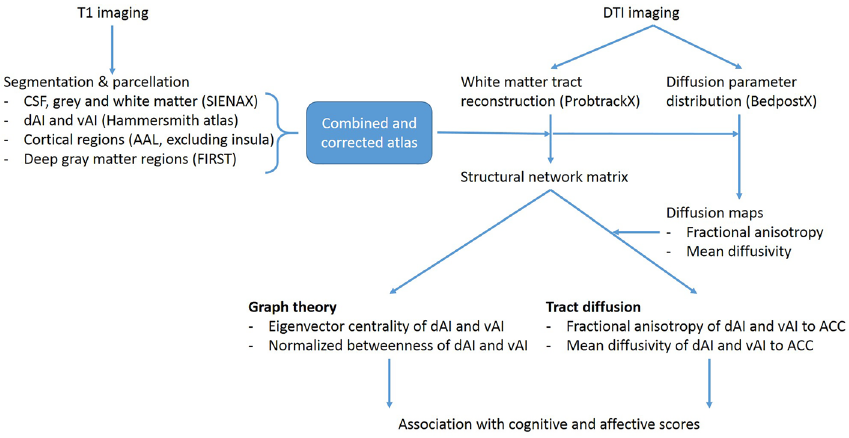
Figure 3. Flowchart of MRI methods and outcome measures. From the T1 images an atlas is constructed which includes the (dorsal and ventral) anterior insula sub-regions from the Hammersmith atlas, as well as